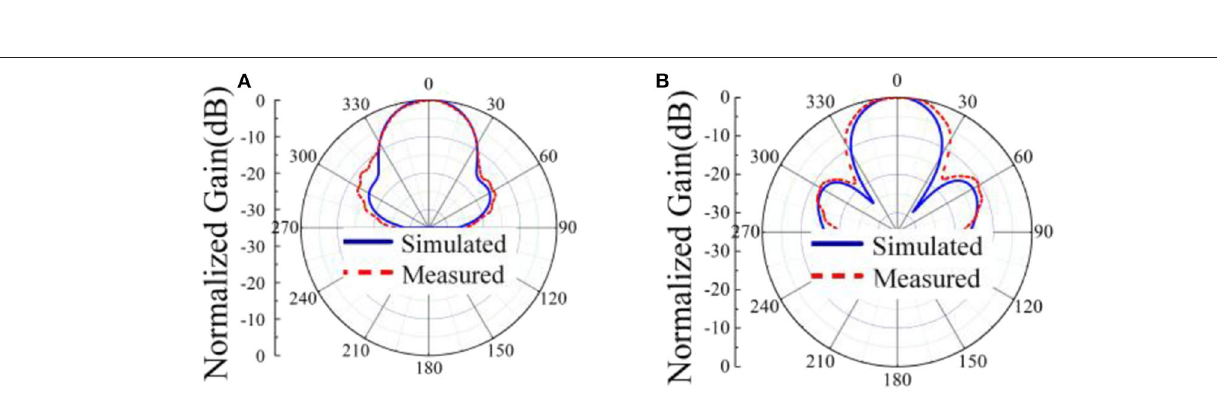
than the type I antenna, while its profile is further reduced to 0.15 λ 0